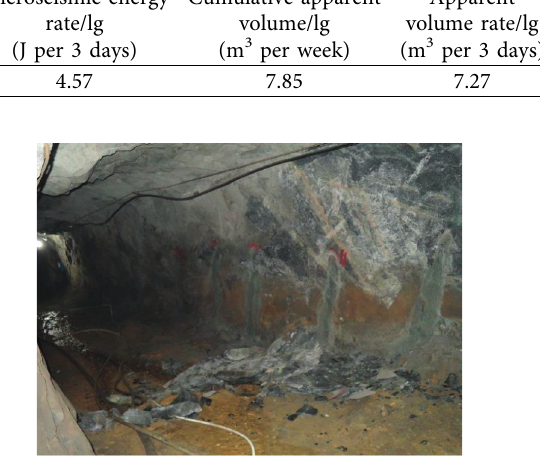
Figure 8: Intense rock burst at the 150 m